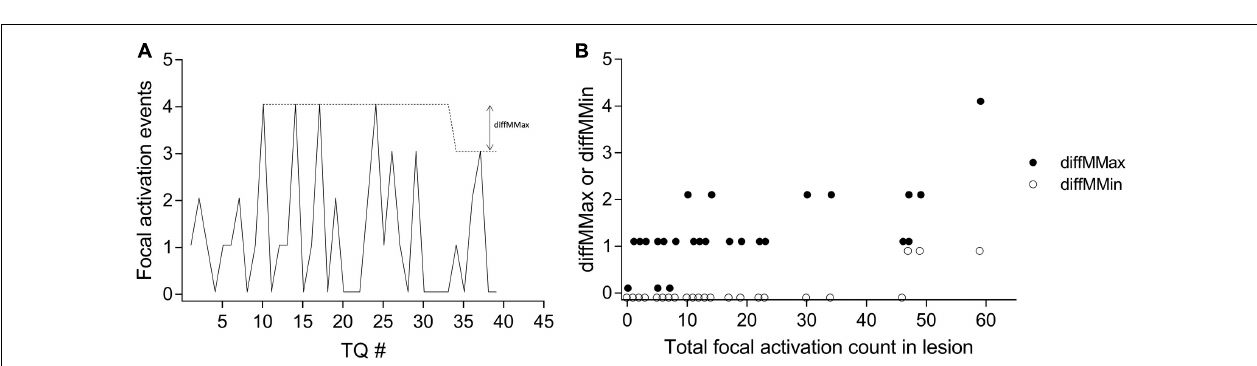
FIGURE 6 | (A) Comparing numbers (mean and SD) of focal activation events with the AFCL response to ablation of that region; ∗ p < 0.05 for Kendall’s correlation between the variables. (B) Counts of focal extinction and activation events within the same regions. Line of best fit and confidence intervals by linear regression are shown ( p < 0.0001).